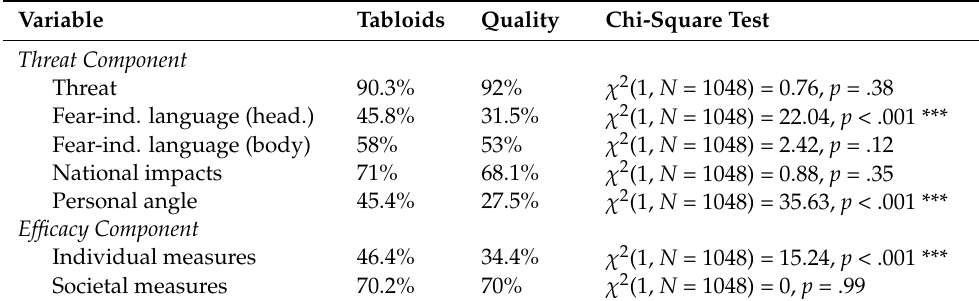
Table 3. Differences between Tabloids and Quality